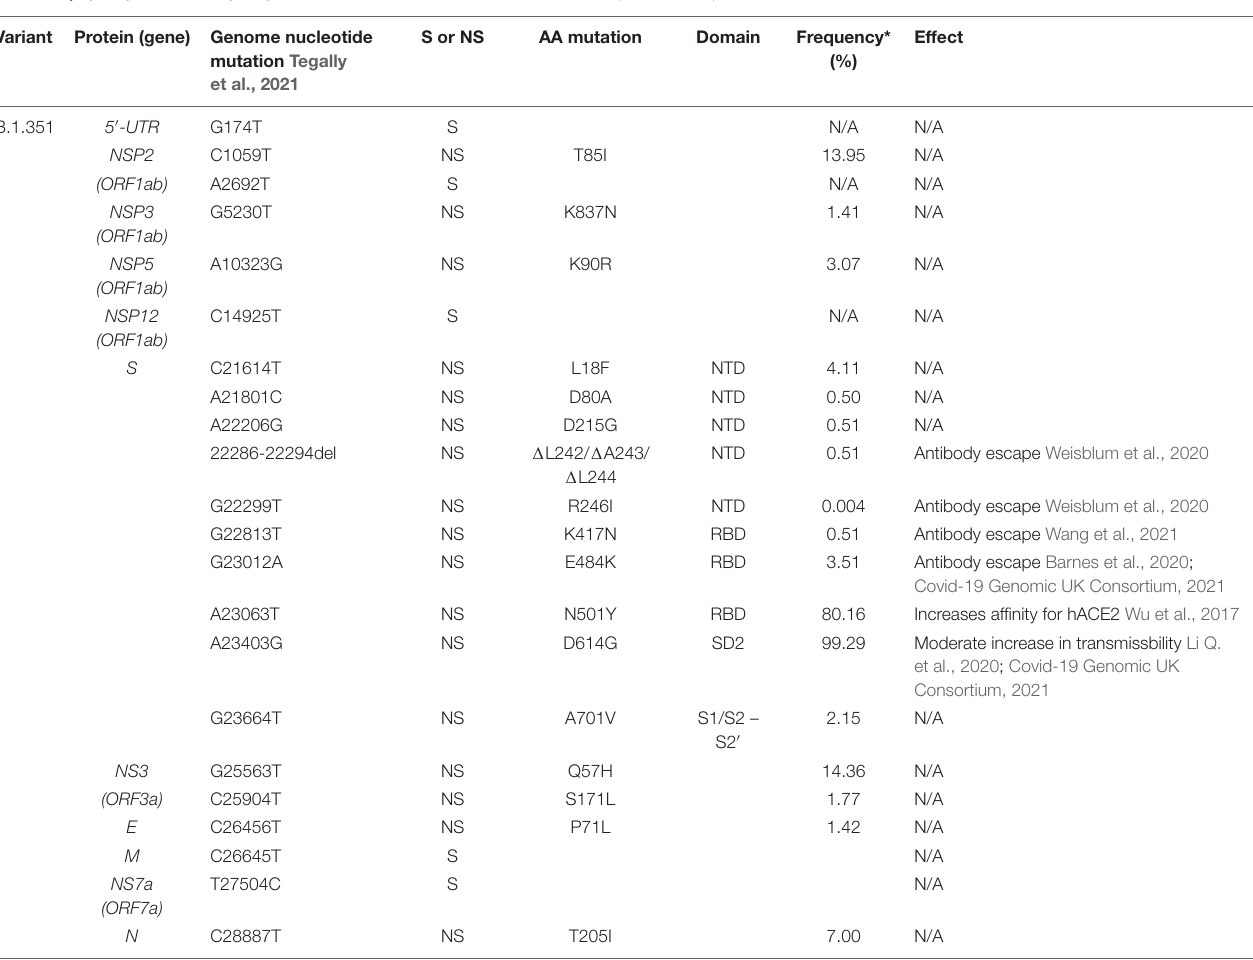
TABLE 3 | Synonymous, non-synonymous mutations and deletions in the B.1.351 (South Africa) variant. Variant Protein (gene) Genome nucleotide mutation